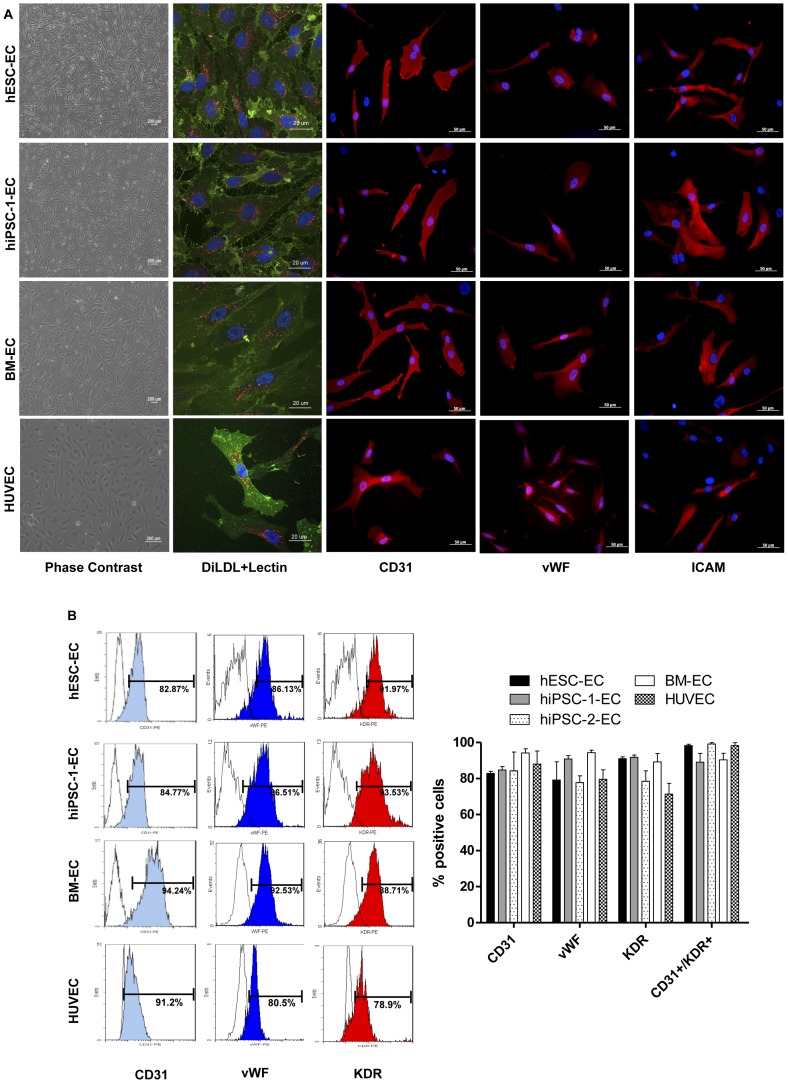
Characterization of derived endothelial-like cells (EC).(A) Phase contrast photos (left panel) showing the morphology of hESC-EC, hiPSC-EC, bone marrow derived EC (BM-EC) and human umbilical cord endothelial cell (HUVEC) in a confluent culture. Immunofluorescence staining showed the expression of typical endothelial cells markers including Ulex europaeus lectin (green) and uptake of Di-Acetyl-LDL (red) (second panel) in hESC-EC, hiPSC-1-EC, BM-EC and HUVEC. Furthermore, expression of CD31, von Willebrand factor (vWF) and intercellular adhesion molecule 1 (ICAM) were also detected in hESC-EC, hiPSC-EC, BM-EC and HUVEC (B) Flow cytometry analysis revealed the expression of CD31, vWF, Kinase insert domain receptor (KDR) in hESC-EC, hiPSC-EC, BM-EC and HUVEC (left panel). There were no differences in the percentage of cells with expression of CD31, vWF, KDR and co-expression of CD31 and KDR between hESC-EC, hiPSC-EC and BM-EC (right panel).